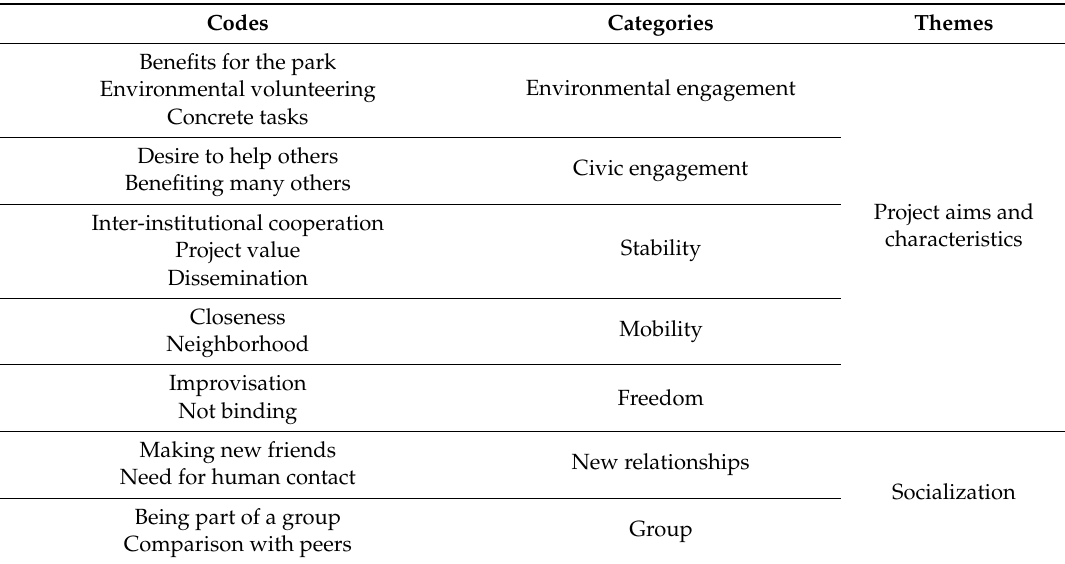
Table 4. Motivation to participate in the